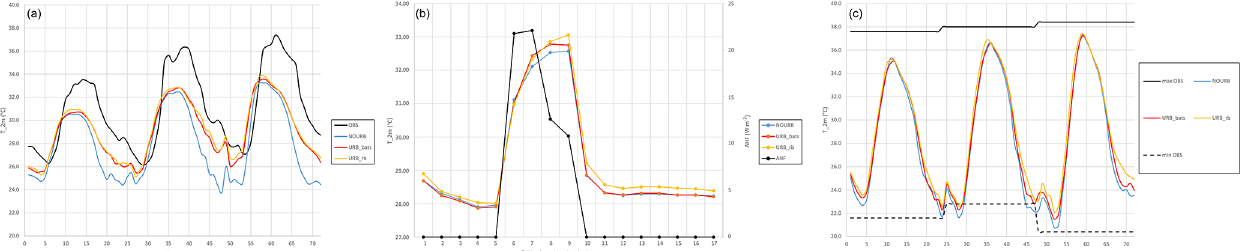
Figure 2. Time series of T_2m over the period 8–10 August 2017 at (a) the urban area of Naples and (c) the rural area of Grazzanise Panel (b) shows the spatial T_2m distribution for Aug 10th 2017 at 13.00 in a series of points close to Naples location.